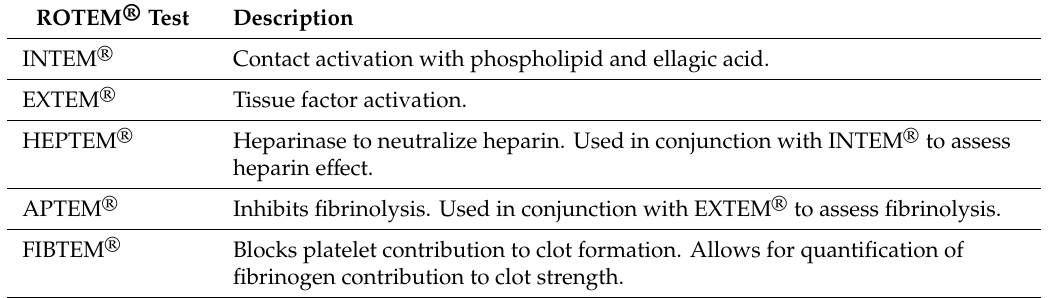
Table 2. Assays developed for the ROTEM ® delta system.